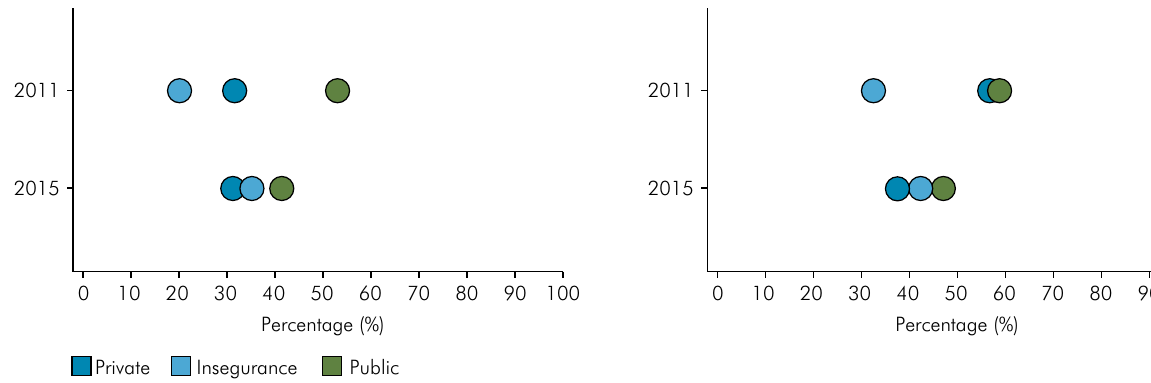
Figure 2. Reduction in (A) inequality of dental caries prevalence, and (B) impact on oral health-related quality of life, according to type of dental service used, among adults residing in Piracicaba, SP, Brazil,